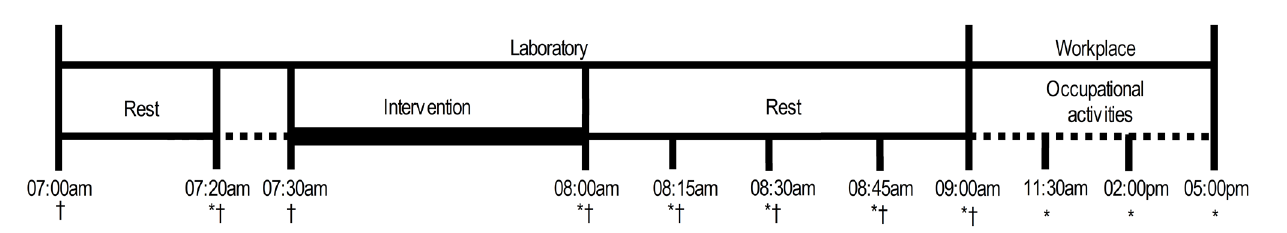
Figure 1. Experimental study design; †Beat-by-beat HR recording; *Blood pressure